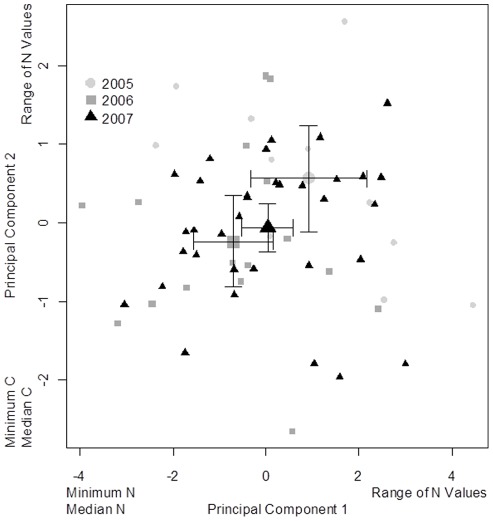
Results of the Principal Components Analysis on the whiskers of 61 bearded seal pups, using the mean, variance, maximum, minimum and range for the δ13C and δ15N for each whisker as variables in the analysis.The variables with the highest loadings are shown at each end of the axes. The mean ± SE principal component scores are also indicted for each of the three years of the study.